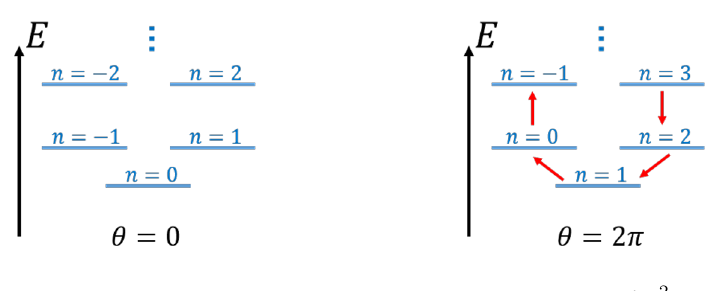
Figure 1 . The energy levels for the particle on a ring are E n = 1 at (cid:18) = 0 and raising it to (cid:18) = 2 (cid:25) , we (cid:12)nd the same structure of energy states, but a nontrivial identi(cid:12)cation of them has occured: the n ’th level has become the n (cid:0) 1’th level. In particular, we must have level crossing for some value of (cid:18) .